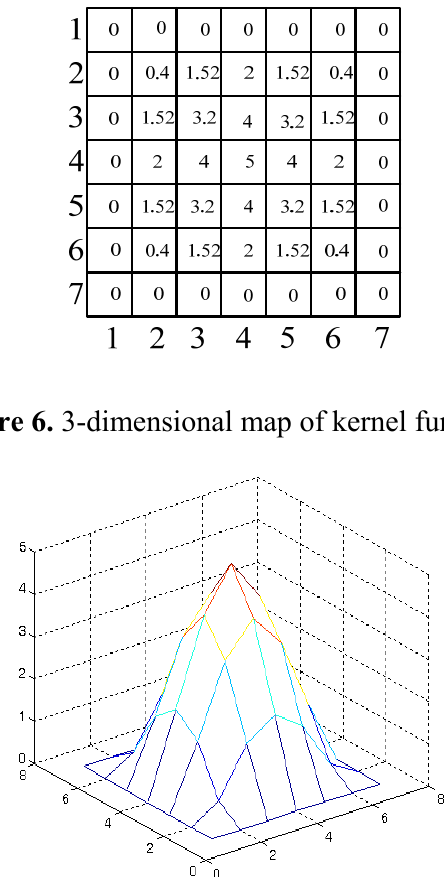
Figure 5. Kernel function weight distribution.